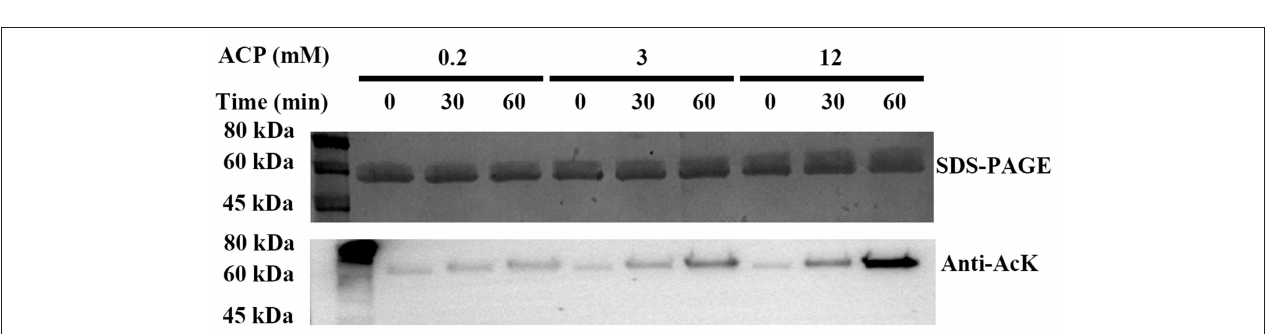
FIGURE 4 | Top line, acetylation of PykF. SDS-PAGE and Western blot analysis were performed on purified PykF treated with AcP in different concentrations and incubation time. The same amount of protein was loaded. Anti-AcK, acetyl lysine antibody. Bottom line, pyruvate kinase activity was measured, and the enzyme activity of lane 1 sample was set as 1. Mean values and standard deviations were calculated based on three replicates ( n = 3). Two-tailed P -values were determined by the t -test, and the significance level is 0.05.